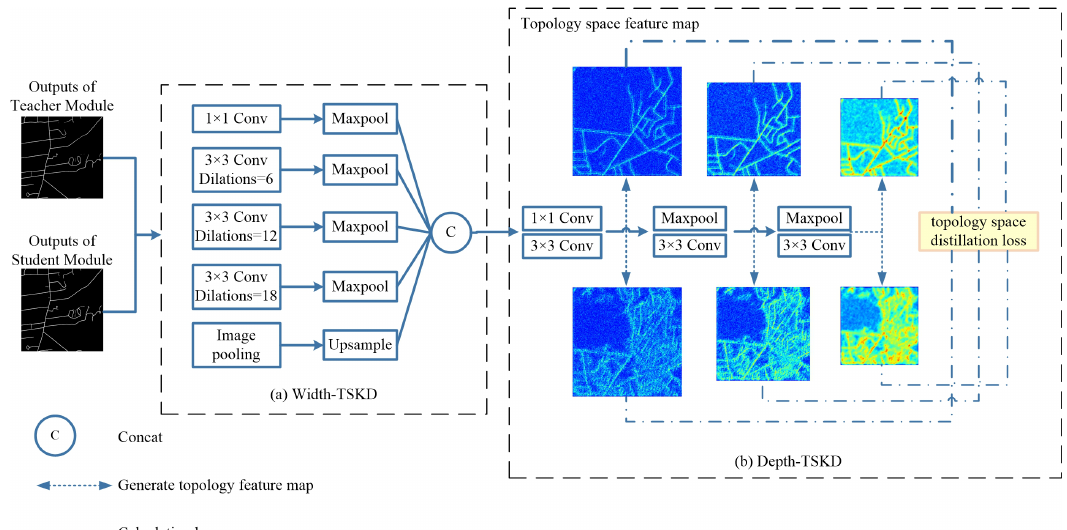
Figure 6. The topological space knowledge distillation (TSKD). It contains two TSKD parts: ( a ) the width-TSKD and ( b ) the depth-TSKD. The former is to extract multi-width topological feature maps, and the latter is to extract multi-depth topological feature